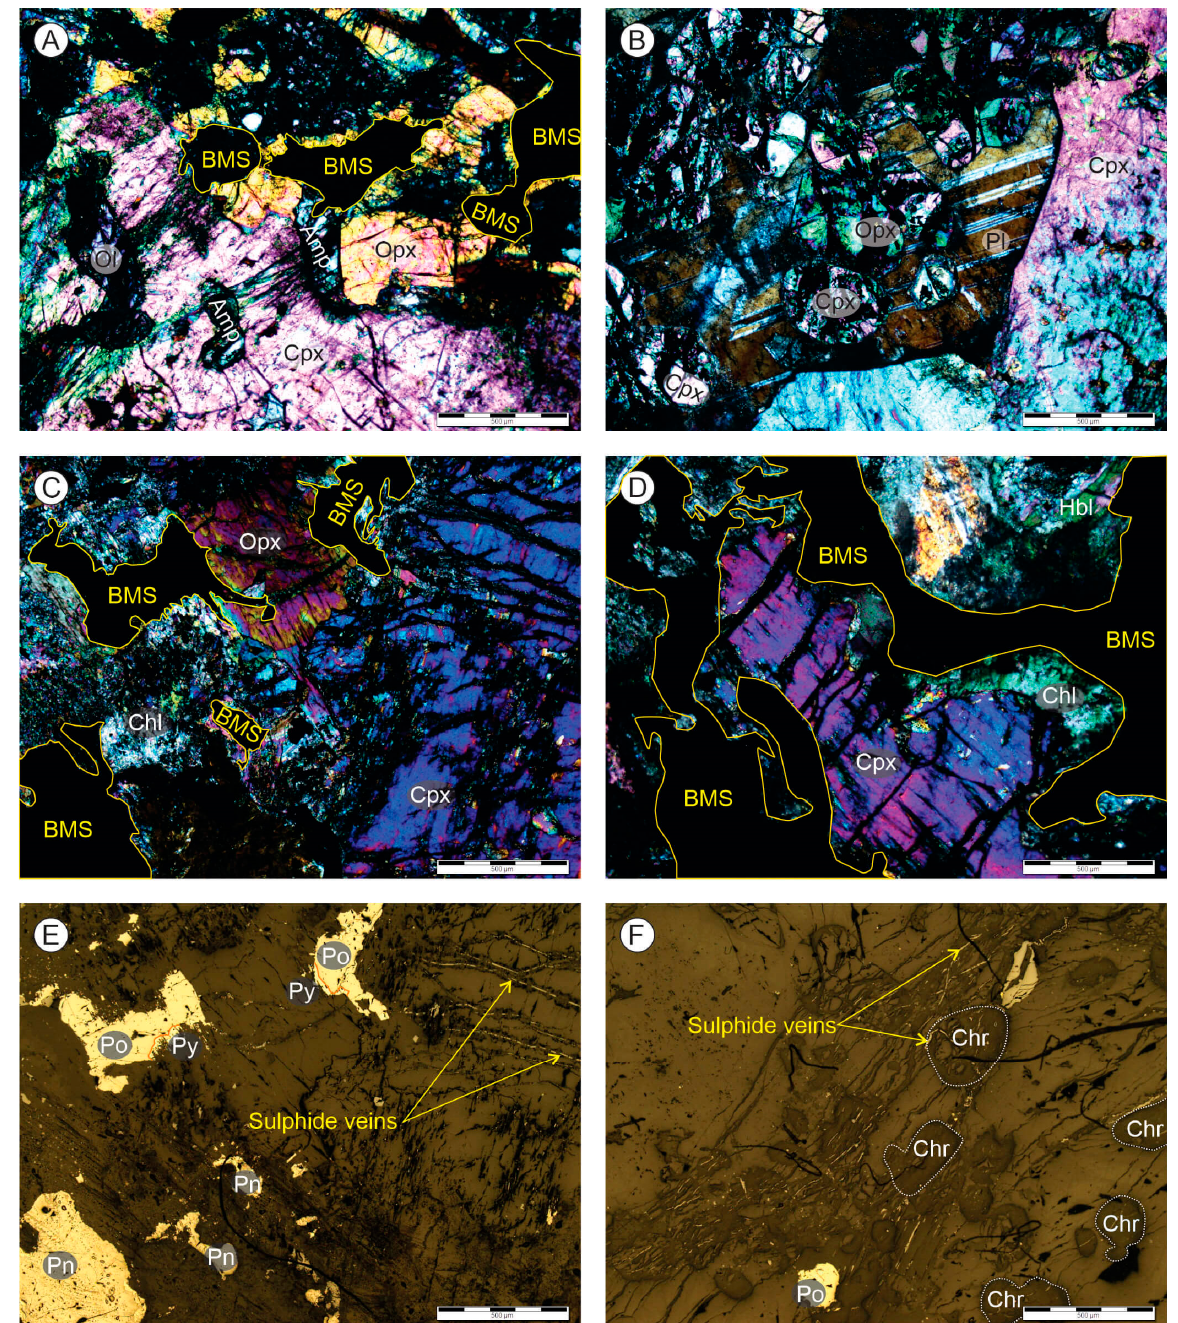
Figure 2. Photomicrographs of the medium-grade and high-grade bleb textured sulfide ores (( A–D ) transmitted plane polarized light; ( E , F ) reflected light). The mineral abbreviations are as follows: amphibole (Amp); chlorite (Chl); clinopyroxene (Cpx); chromite (Chr); glaucophane (Gln); hornblende (Hbl); orthopyroxene (Opx); oxide (Ox); plagioclase (Pl); chalcopyrite (Ccp); pentlandite (Pn); pyrrhotite (Po); pyrite (Py); serpentine (Srp); and talc (Tlc). The scale bar at the bottom right of the images represents 500 µm. BMS = base metal sulfides.